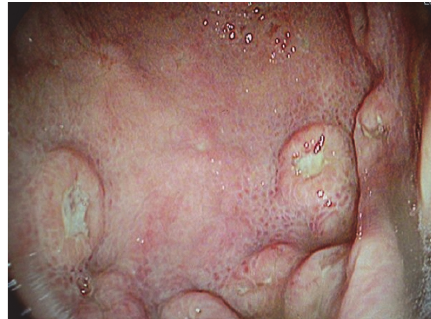
Figure 1: Endoscopic image of the stomach.